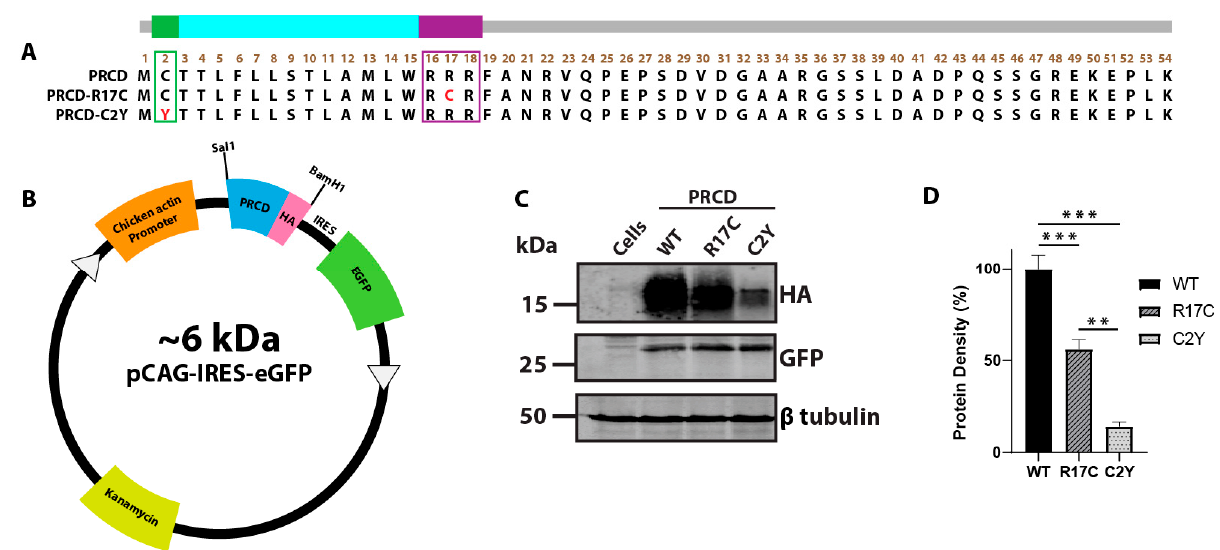
Figure 1. Arginine 17 in PRCD is essential for protein stability. ( A ) the amino acid sequence of PRCD protein depicting PRCD-WT, PRCD-R17C, and PRCD-C2Y. The green area indicates the site of palmitoylation at the second cysteine residue, and the most common mutation “Cys2Tyr” is indicated in red. The purple box depicts the polybasic region from the 16–18 aa and the R17C mutation is shown in red. The transmembrane helix is coded blue from the third to the fifteenth aa. ( B ) cloning cassette scheme demonstrating the PRCD wildtype and mutants tagged with HA (hemagglutinin) expressed under a chicken actin promoter. In addition, eGFP expressed independently under IRES (Internal Ribosome Entry Site) serves as an internal control. ( C ) immunoblot of PRCD-WT, R17C, and C2Y transiently transfected in hRPE1 cells. GFP serves as an internal control, with β tubulin being a loading control. ( D ) quantification of PRCD proteins identified in C ( n = 3). The expression of PRCD was normalized to the internal GFP control (**, p < 0.005 and ***, p < 0.0005) based on a one-tailed Student t -test.